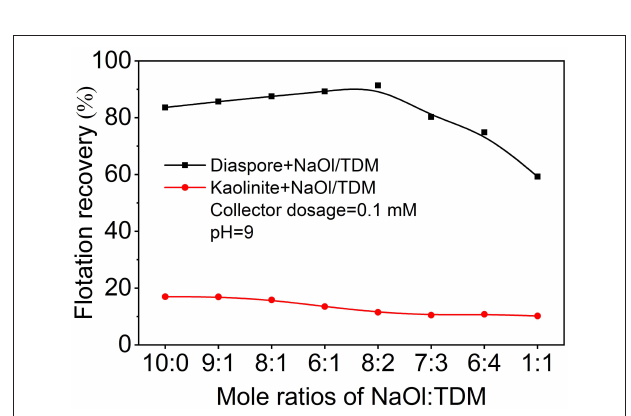
FIGURE 3 | Effect of the molar ratio of NaOl to TDM (Collector dosage = 0.1mM, pH = 9) on the flotation recovery of diaspore and